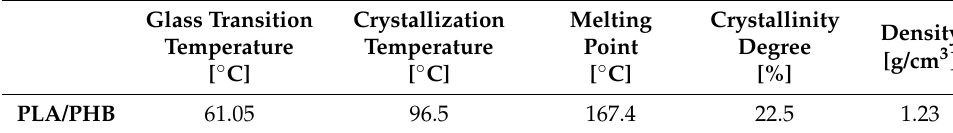
Table 2. Thermo-Physical Properties of Material